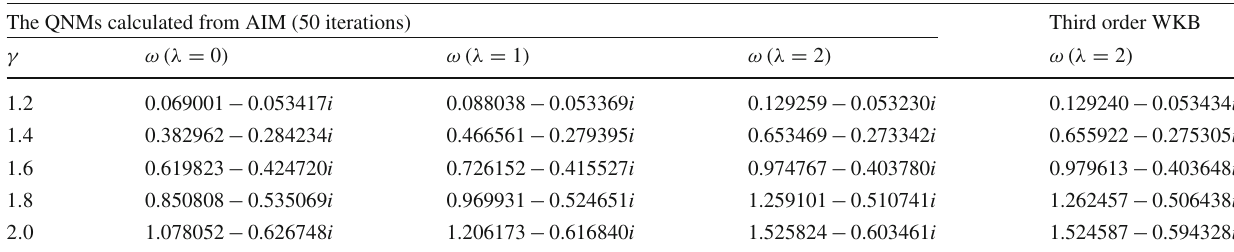
Table 2 The QNMs for massive scalar perturbations of a neutral black string for M = 1 ,α g = 1 ,(cid:14) = 0 ,α 2 m = − 0 . 25 , m s = 0 . 5 , k = 0 The QNMs calculated from AIM (50 iterations)